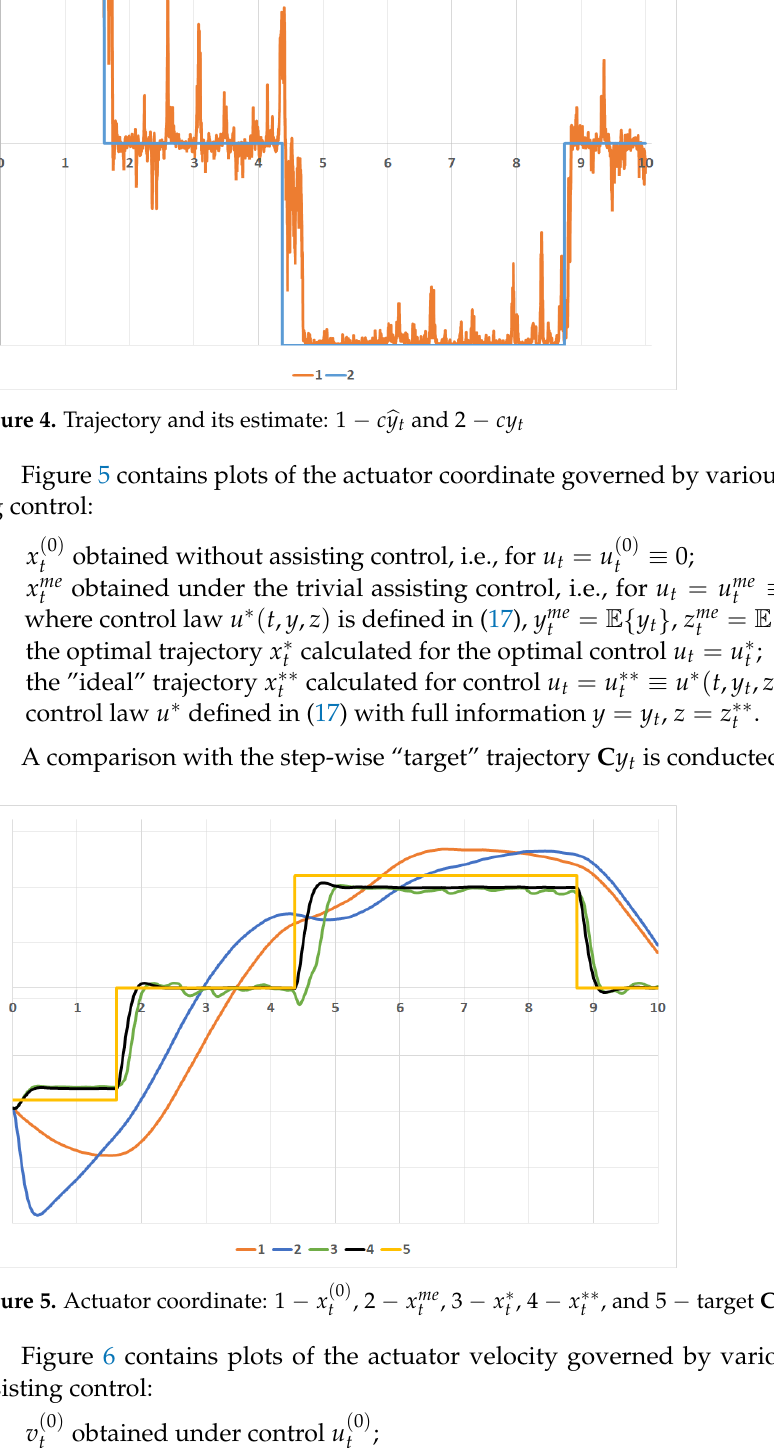
( 0 ) , 2 − x me , 3 − x ∗ t , 4 − x ∗∗ t , and 5 − target C y t t t